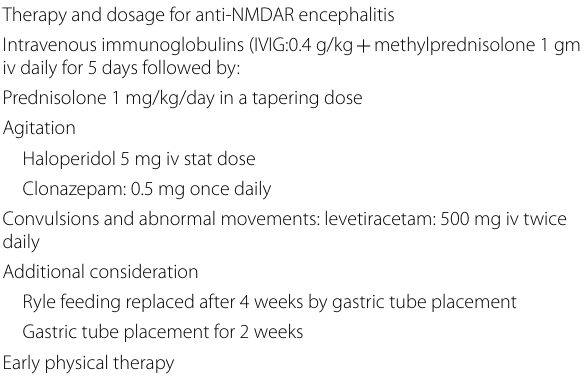
methylprednisolone 1 gm +